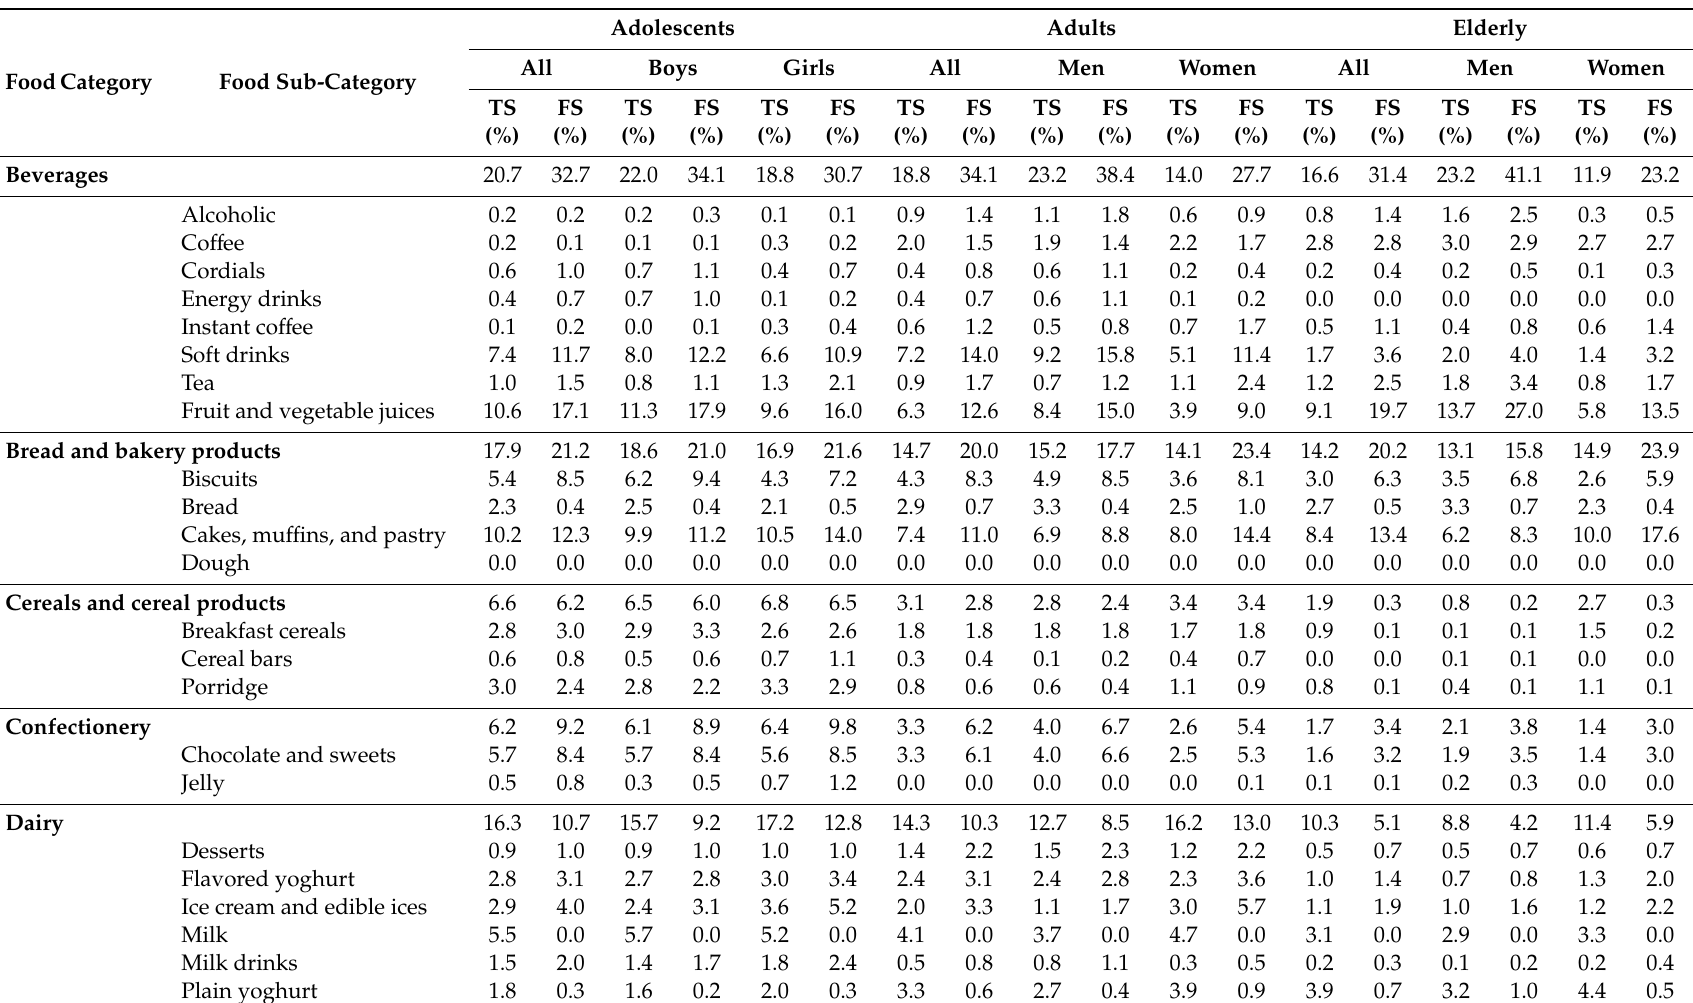
Table 4. Mean contribution (%) to the total and free sugars intake by selected food